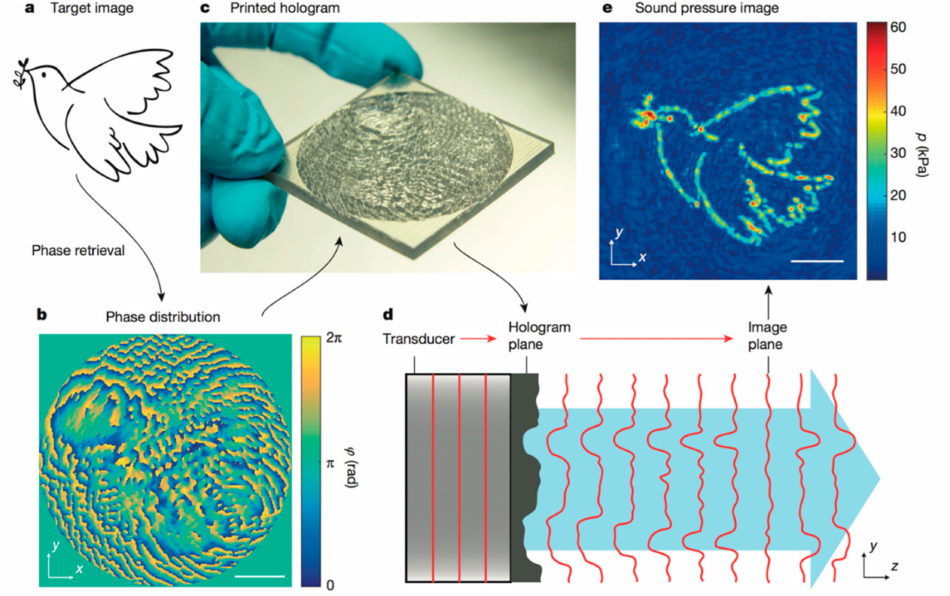
Figure 4. Acoustic holography can be used to form arbitrary pressure field images. The target image ( a ) is used to backward calculate the required phase distribution ( b ). The 3D printed transmission hologram, as a height topography in a phase plate ( c ), is placed in front of the transducer ( d ) to acquire the sound pressure image ( e ). Scale bar: 10 mm. Reprinted with permission from